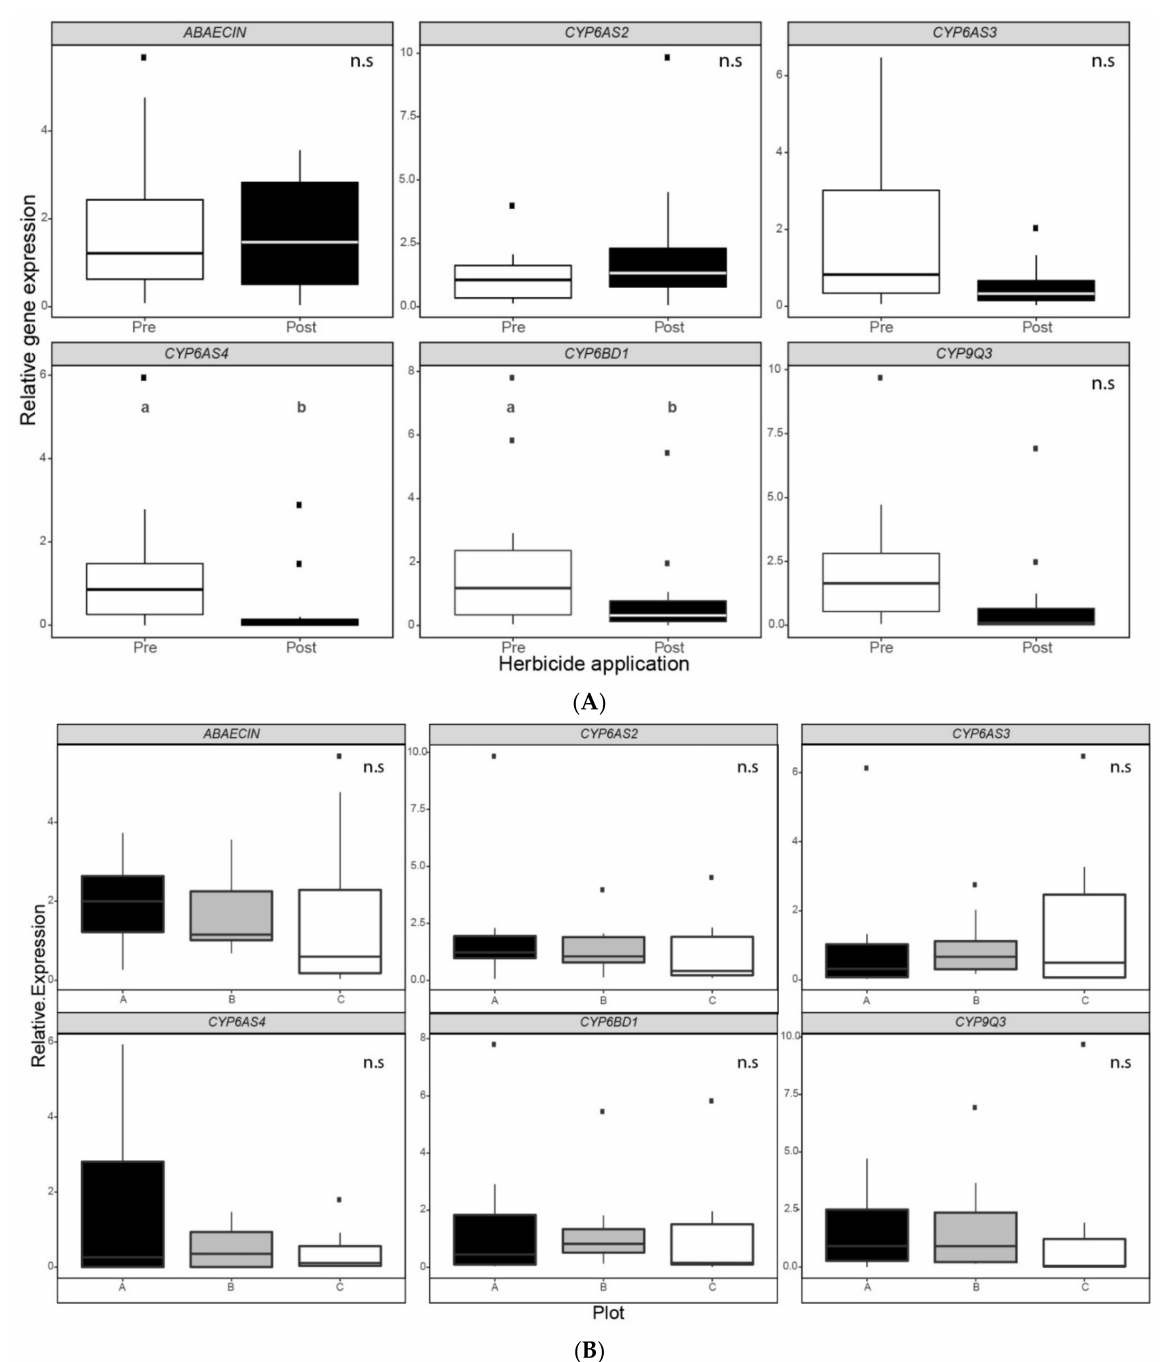
Figure 4. Gene expression in larvae, ( A ) before and after post-emergence weed control and ( B ) for each plot. Relative expression levels of the antimicrobial peptide Abaecin (AB) and P450 cytochromes (CYP6AS2 , CYP6AS3 , CYP6AS4 , CYP6BD1 and CYP9Q3 ) in five polled fifth instars sampled from randomly selected colonies. Relative gene expression was assessed by real-time quantitative reverse transcription amplification (qRT-PCR). Data are presented as a fold change expression normalized to the endogenous reference gene Rpl8 , calculated by ∆∆ CT method. Boxplots show the median and interquartile range (IQR), with whiskers showing the maximum value within 1.5 IQR, and individual points mark values outside this range. Different letters indicate significant differences between application moments ( p < 0.05, N = 12, Wilcoxon paired test). No significant differences (n.s.) were found between plots for any of the genes studied (N = 12, Friedman rank sum